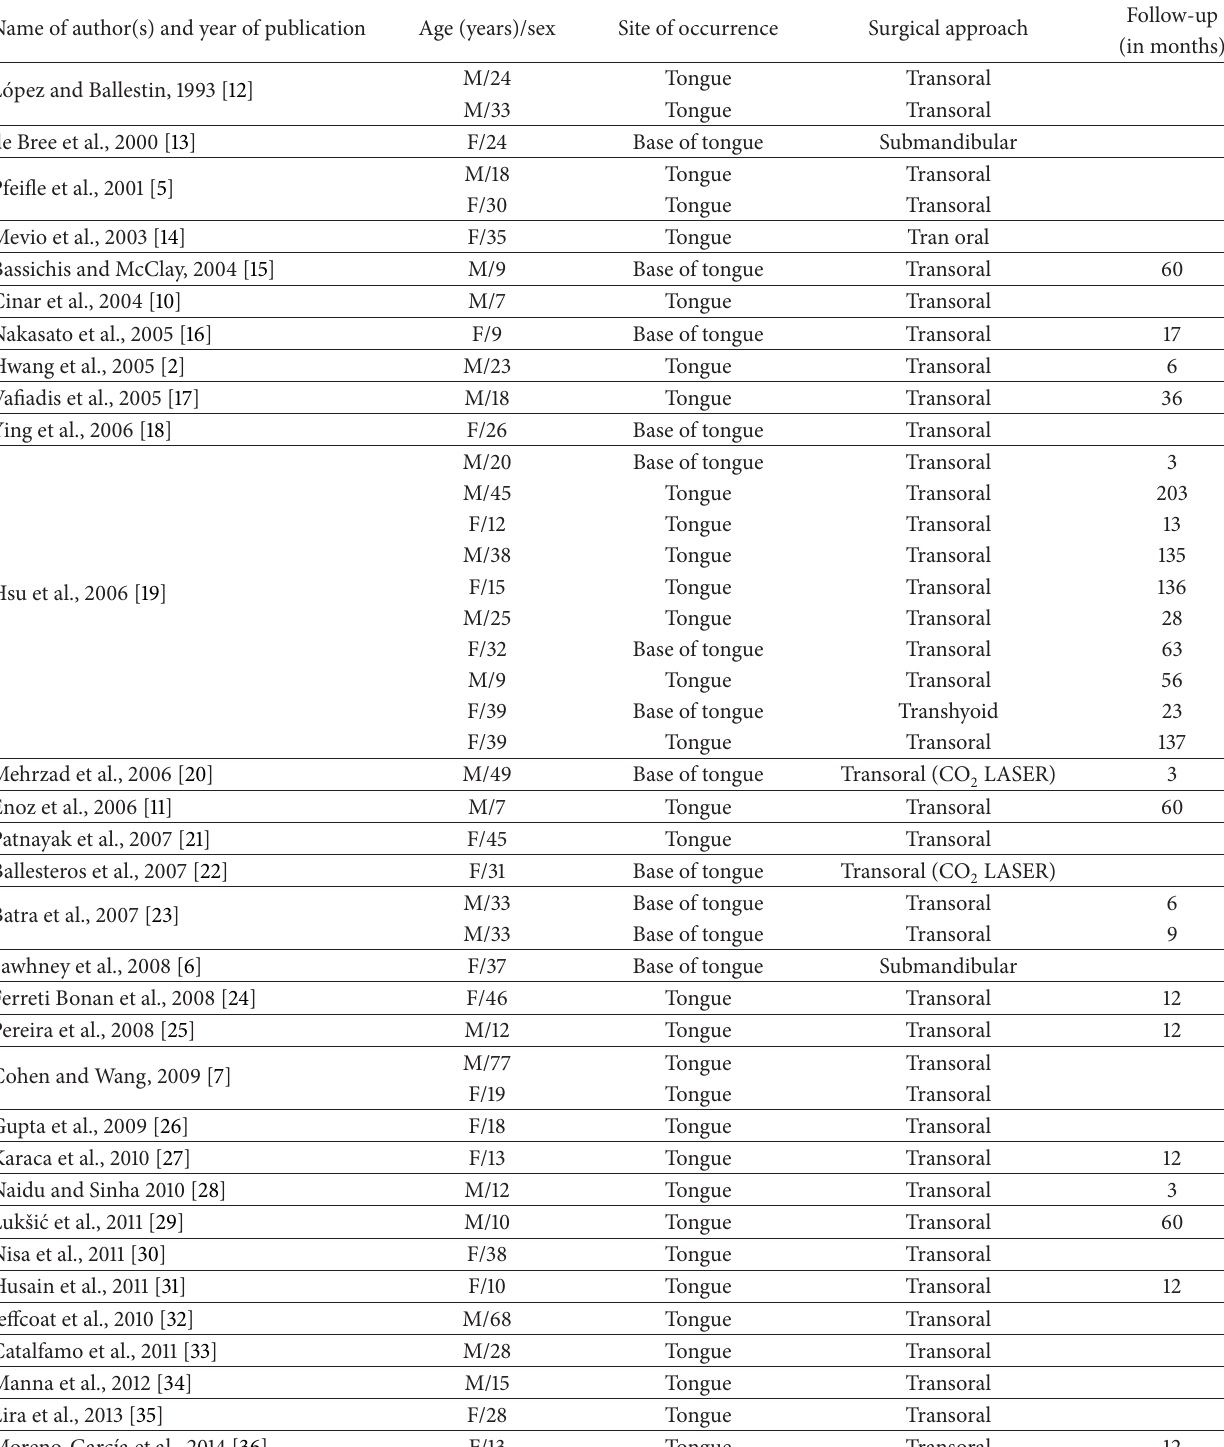
Table 1: Demographic characteristic of cases reported in past 20 years’